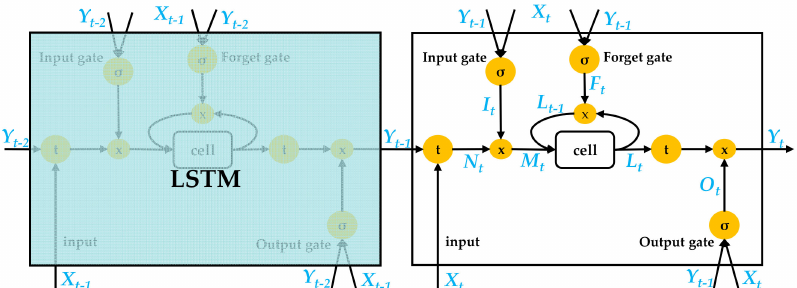
Figure 5. The inner structure of long short-term memory (LSTM), where a circle with a σ represents an activation function and a circle with a x represents multiply function. I t , F t , O t are the output information of input, forget and output gates; and these three control value are all connected with the input X t and the output of the previous moment Y t − 1